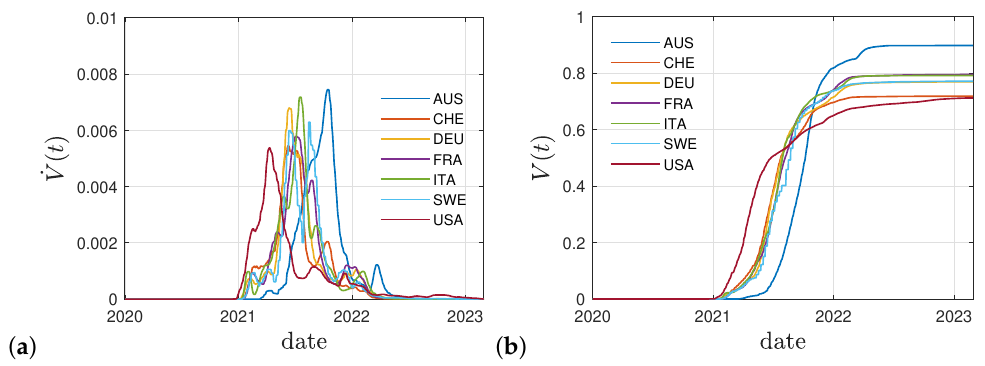
Figure 4. ( a ) Daily fraction and ( b ) cumulative fraction of fully vaccinated persons in Australia (AUS), Switzerland (CHE), Germany (DEU), France (FRA), Italy (ITA), Sweden (SWE) and the United States (USA). The raw data were retrieved from [38].